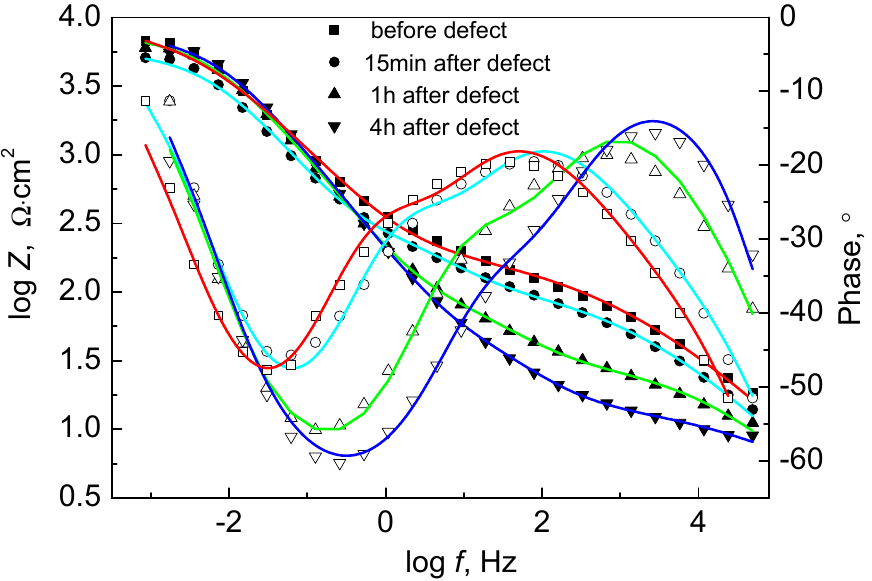
Figure 9. Impedance spectra of Fe/P-Mo-Ce2 in 0.5 M NaCl solution before and after sample scratching.